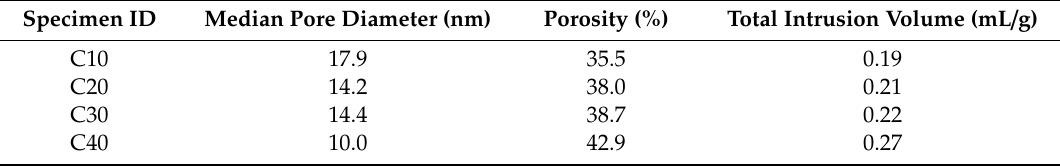
Figure 6. Mercury intrusion porosimetry test results of the mixtures of slag and CCR: ( a ) log differential intrusion curve and ( b ) cumulative intrusion curve. Table 3. Pore characteristics of mixture of slag and CCR as measured by